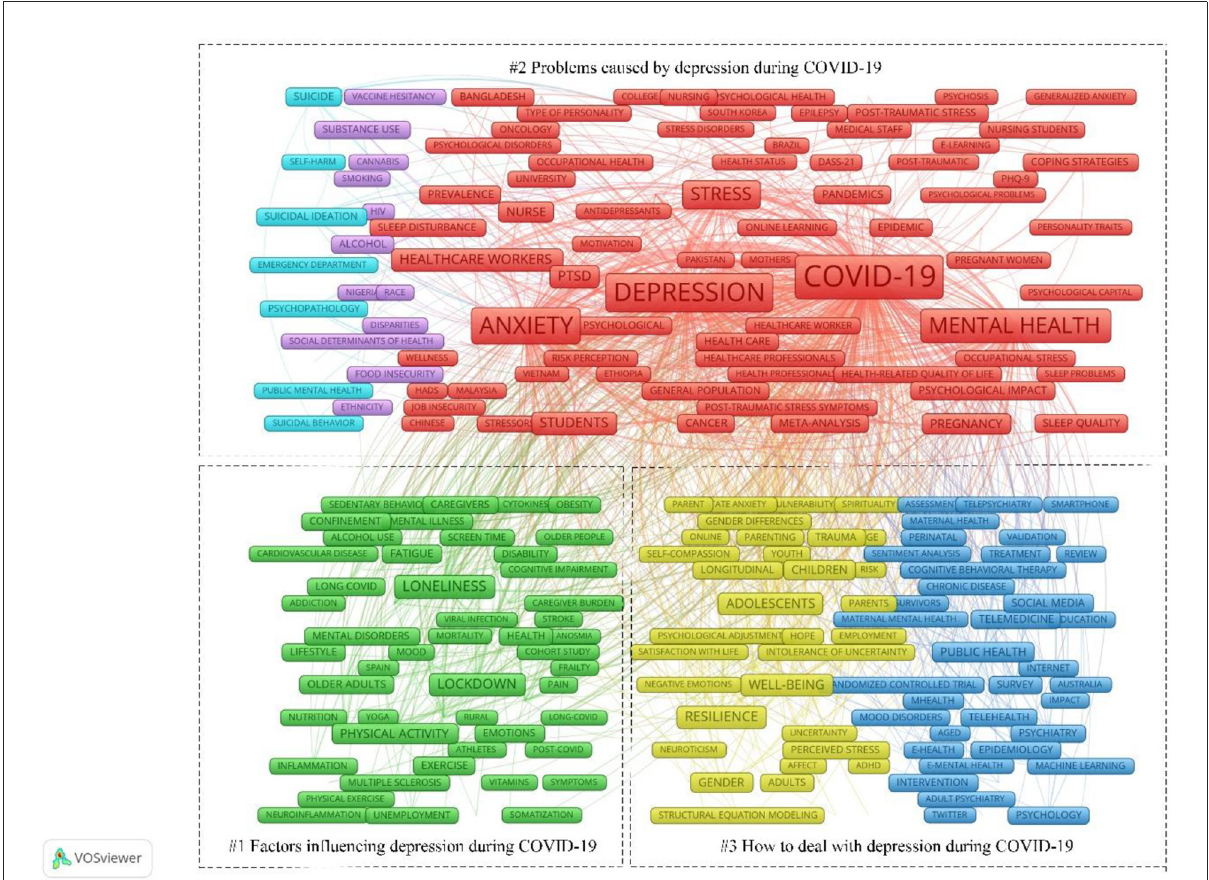
FIGURE8 Map of keywords. The nodes represent keywords. The lines represent co-occurrence relationships. Green represents “Factors influencing depression during COVID-19.” Light blue, purple, and red represent “Problems caused by depression during COVID-19.” Dark blue and yellow represent “How to deal with depression during